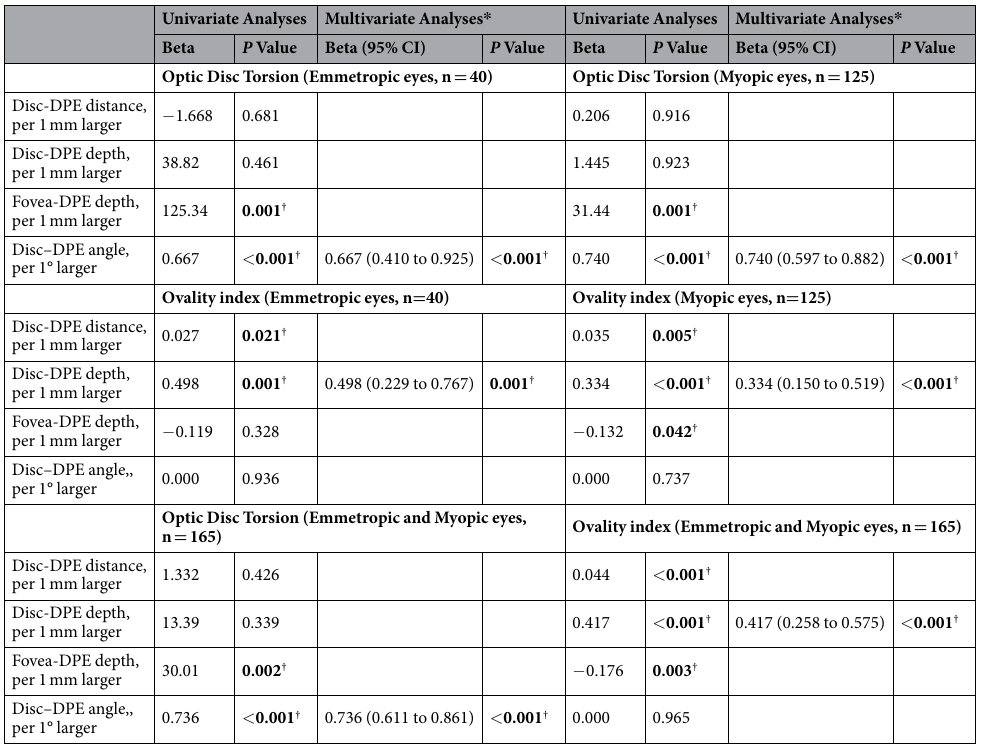
Table 6. Univariate and multivariate regression analyses of optic disc torsion and ovality index on emmetropic eyes and myopic eyes * . CI = confidence interval, DPE: deepest point of the eyeball. * Variables with P < 0.05 in univariate analyses were included in multivariate analyses. † Statistically significant values ( P < 0.05) are shown in bold. The English in this document has been checked by at least two professional editors, both native speakers of English. For a certificate, please see: http://www.textcheck.com/certificate/GrHOaJ.